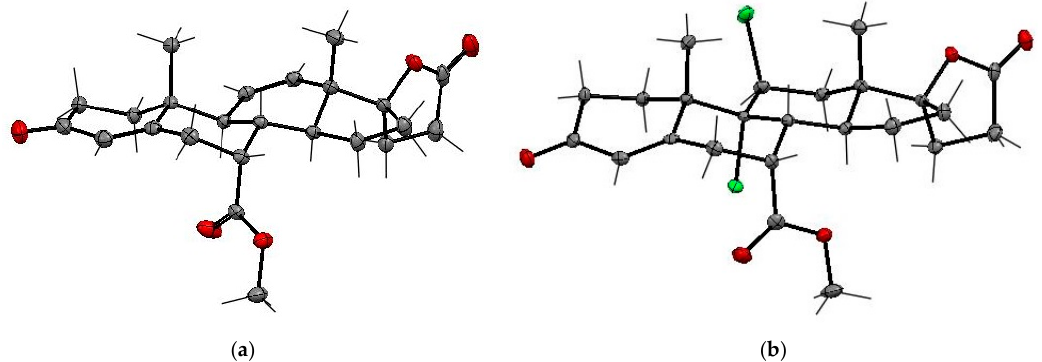
Figure 7. Molecular structure of ( a ) (7 α ,17 α )-11-enester 7b and ( b ) (7 α ,11 β ,17 α )-9,11-dichloro derivative 13 .